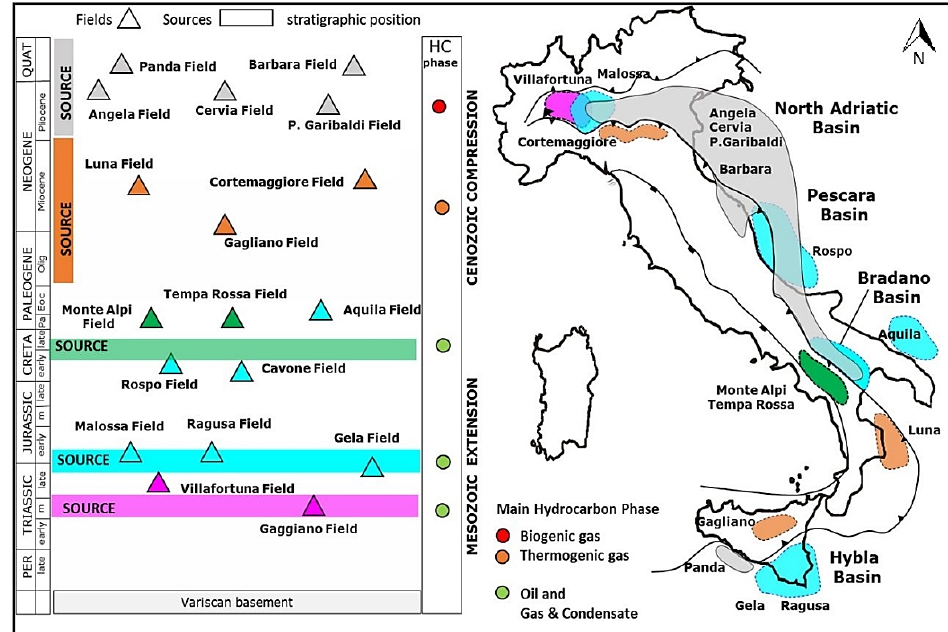
Figure 1. Simplified stratigraphic and geographic location of the Italian petroleum systems (Modified from [30]. Copyright Geological Society of London, 2018).